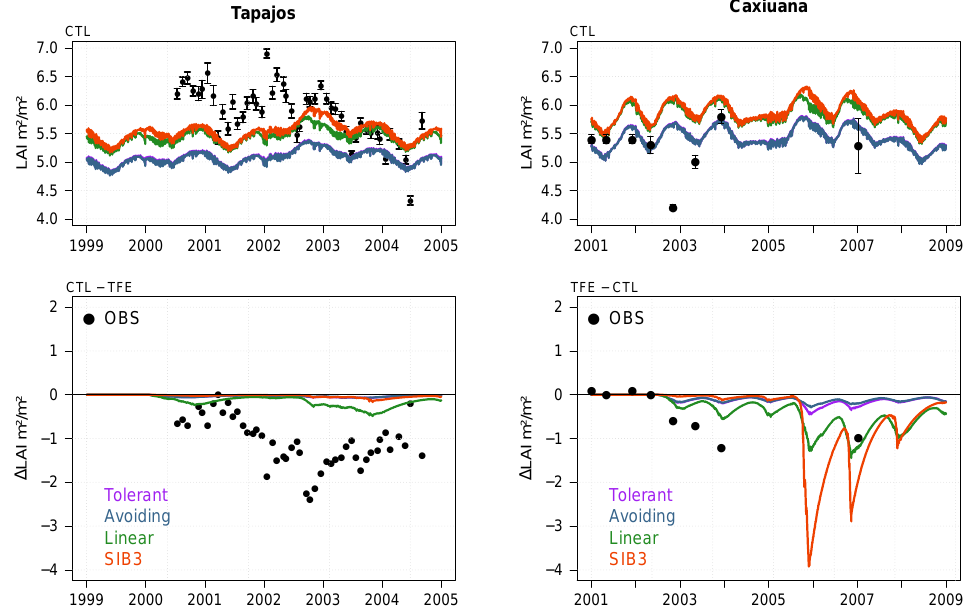
Figure 9. Times series of the daily leaf area index (LAI) for the control plot (top) and the difference between the exclusion and control plot (bottom) at Tapajós (left) and Caxiuanã (right).